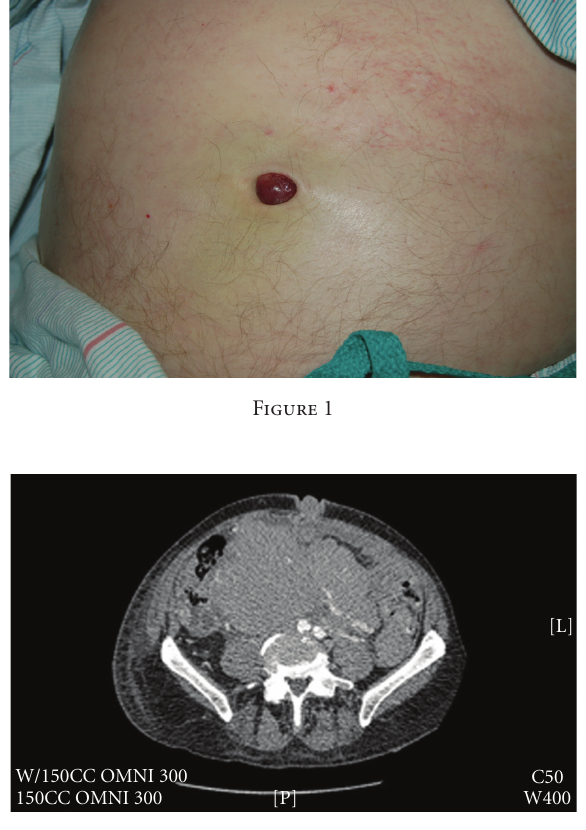
the diaphragm, the retroperitoneum, and the right